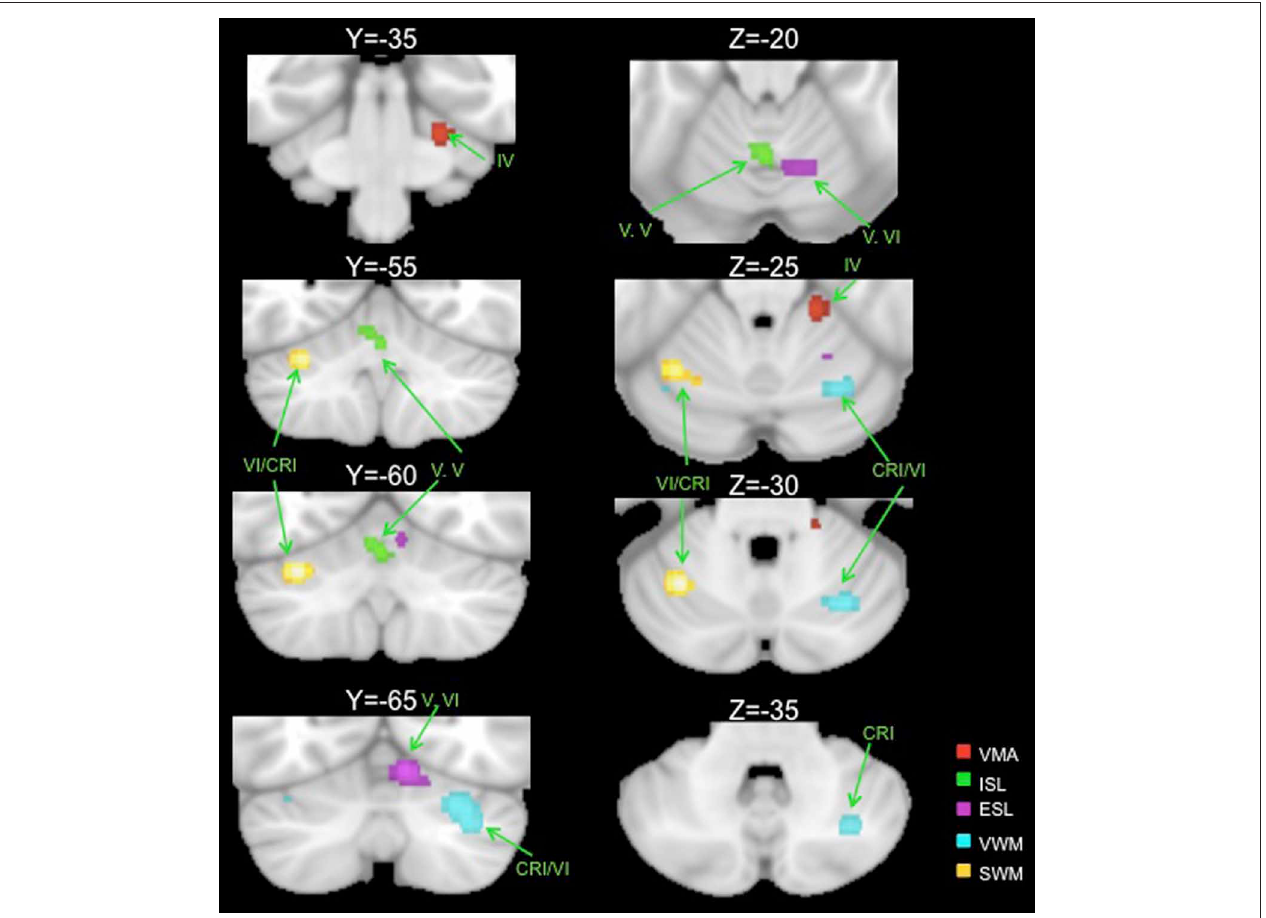
FIGURE 2 | Significant ALE clusters of activation for each examined task type are presented on coronal (left) and axial (right) slices of the cerebellum. All clusters are thresholded and corrected for multiple